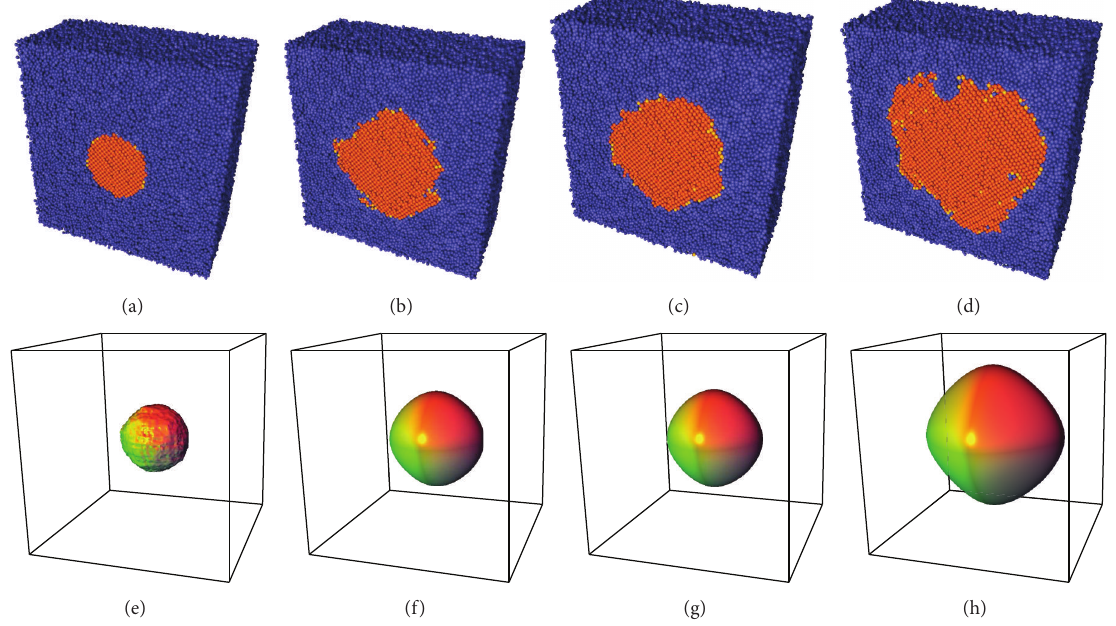
Figure 2: Snapshots of the simulations at 1550K. MD simulations at (a) initial time 80ps, (c) 100ps, and (d) 220 ps. The evolution of the crystalline cluster from PF simulations with the same volume is shown in the sequence from (e) to (h).